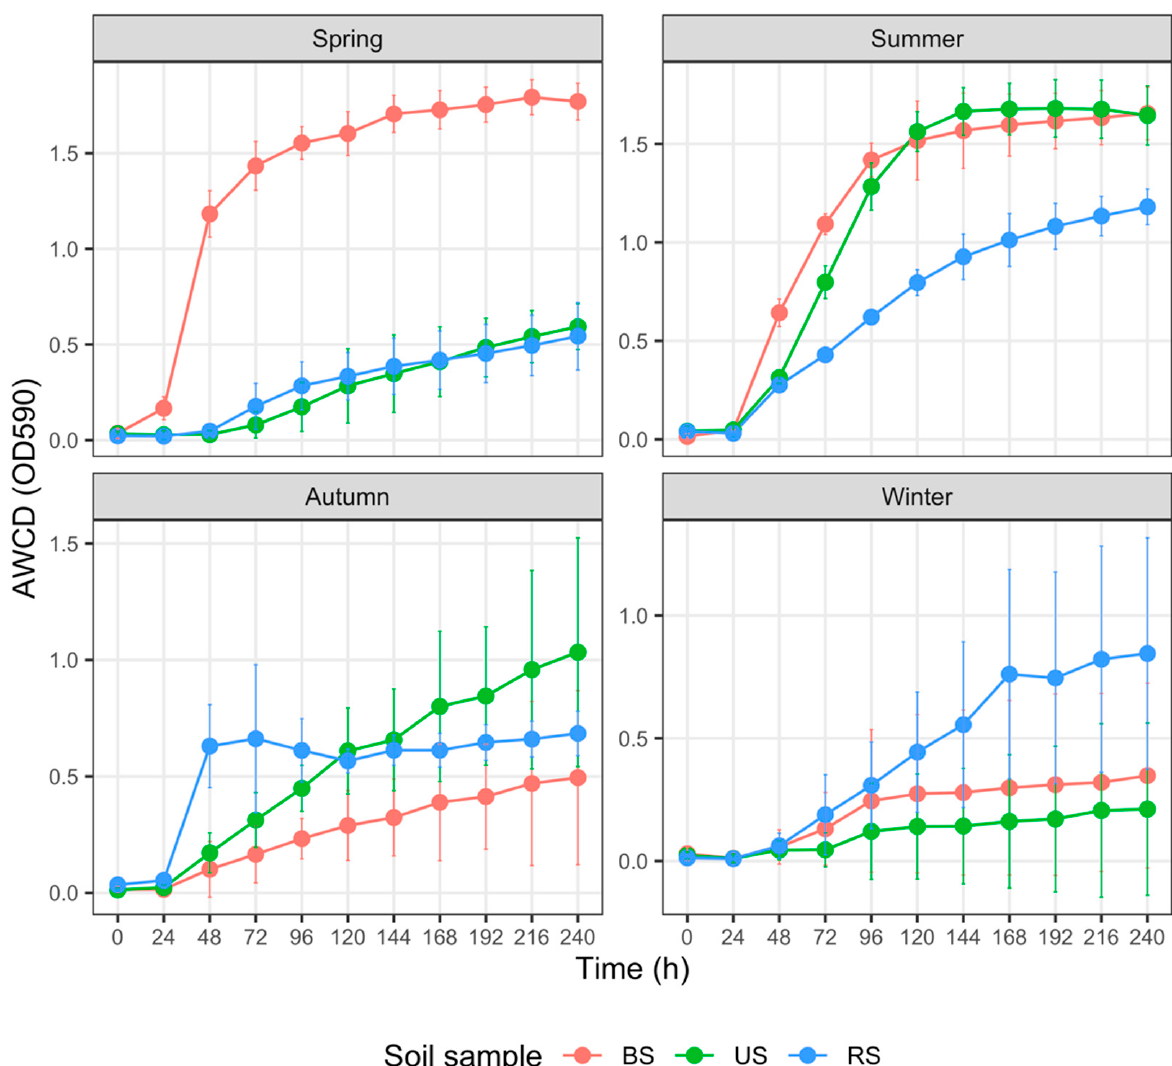
Figure 4. Variation in the average well color development (AWCD) of carbohydrates among three groups of soil samples collected in different seasons. The error bar represents the mean ± SD ( n = 3). AWCD values at the 240th h for each soil sample were compared using the Kruskal–Wallis test.